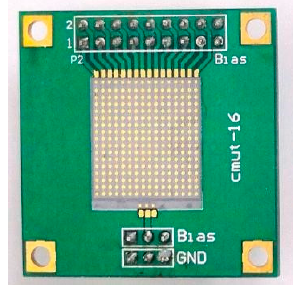
Figure 13. Picture of the CMUT.